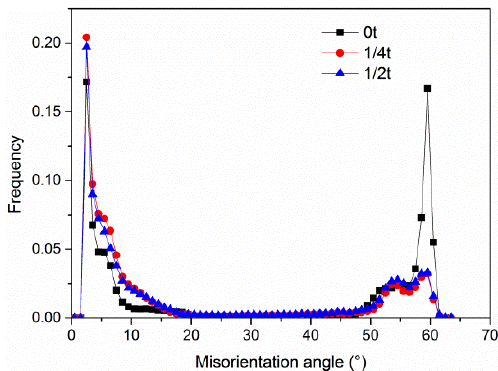
Figure 7. Frequency of grain boundaries at three positions.